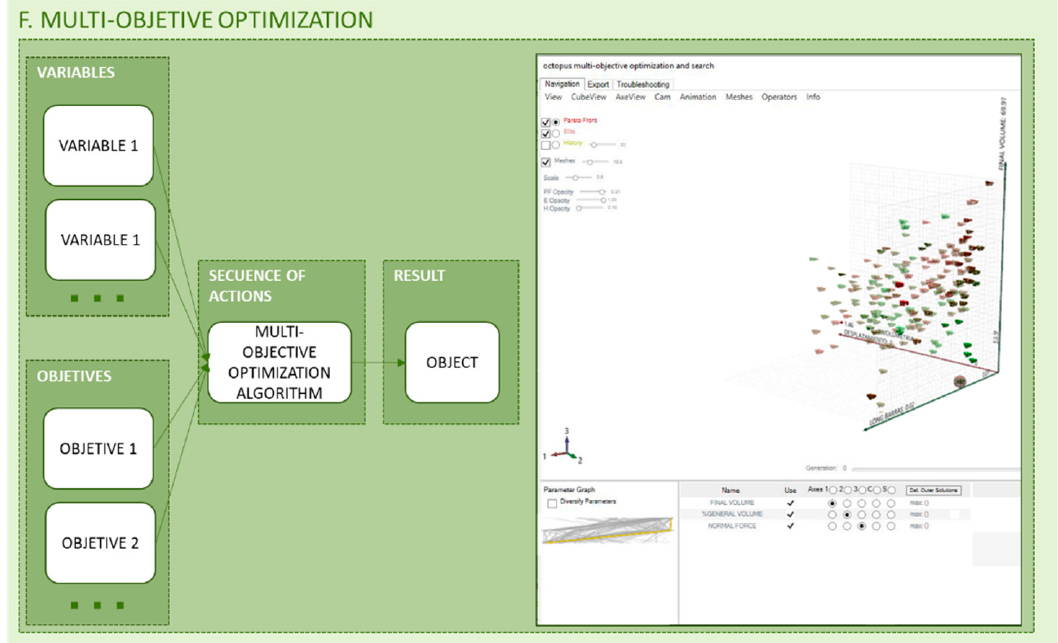
Figure 14. Programming structure of multi-objective optimization. Table 2. Multi-objective optimization parameters applied to the beam